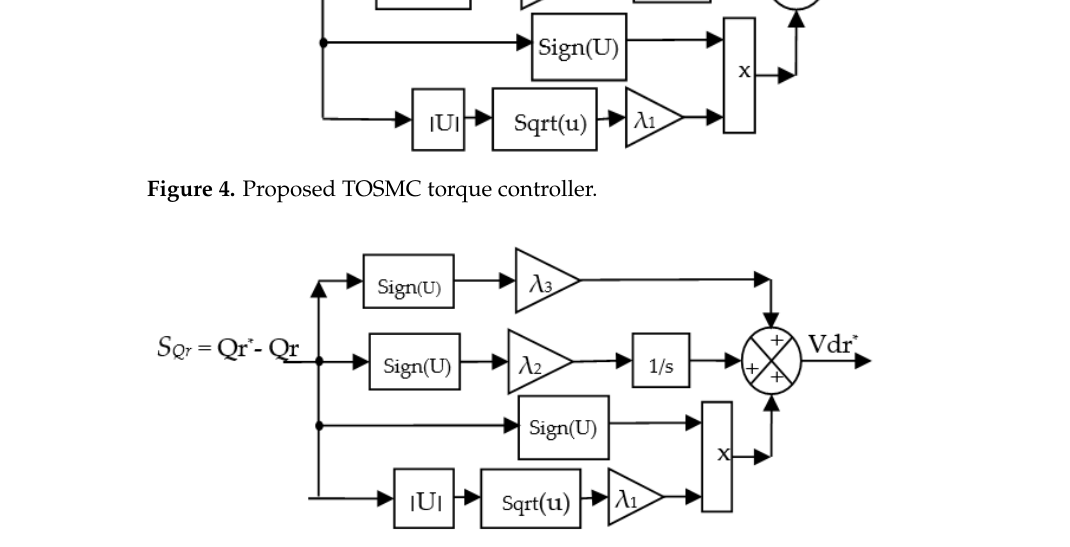
0 Figure 6. THD value of the stator current Figure 6. THD value of the stator current (DFTC-PI).